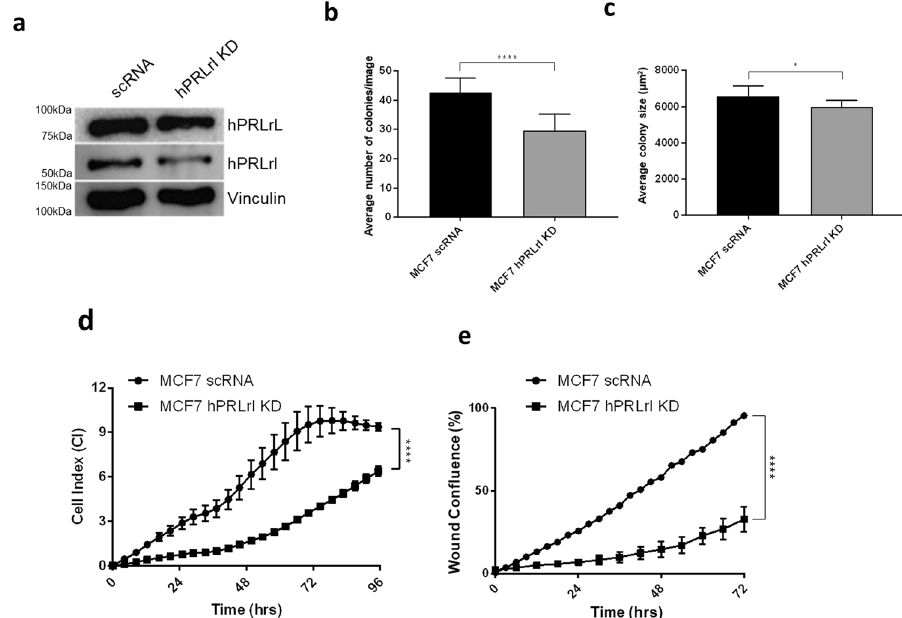
Fig. 3 In vitro knock-down of hPRLrI in MCF7 cells. a MCF7 cells were stably transfected with either scrambled RNA (scRNA) negative control or shRNA targeting the hPRLrI splice site. These transfectants were analyzed for differential anchorage-independent growth via soft agar assay, quantifying both b colony number and c colony size, using CellPro fi ler. Transfectants were further assessed for d proliferative potential and e ability to migrate. * p < 0.05, **** p < 0.001, n = 3. Data is shown as mean ±